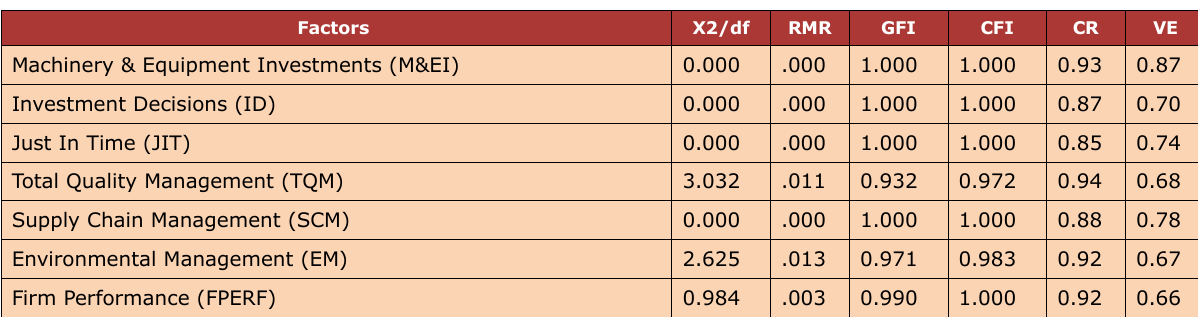
Table 3. Confirmatory Factor Analysis